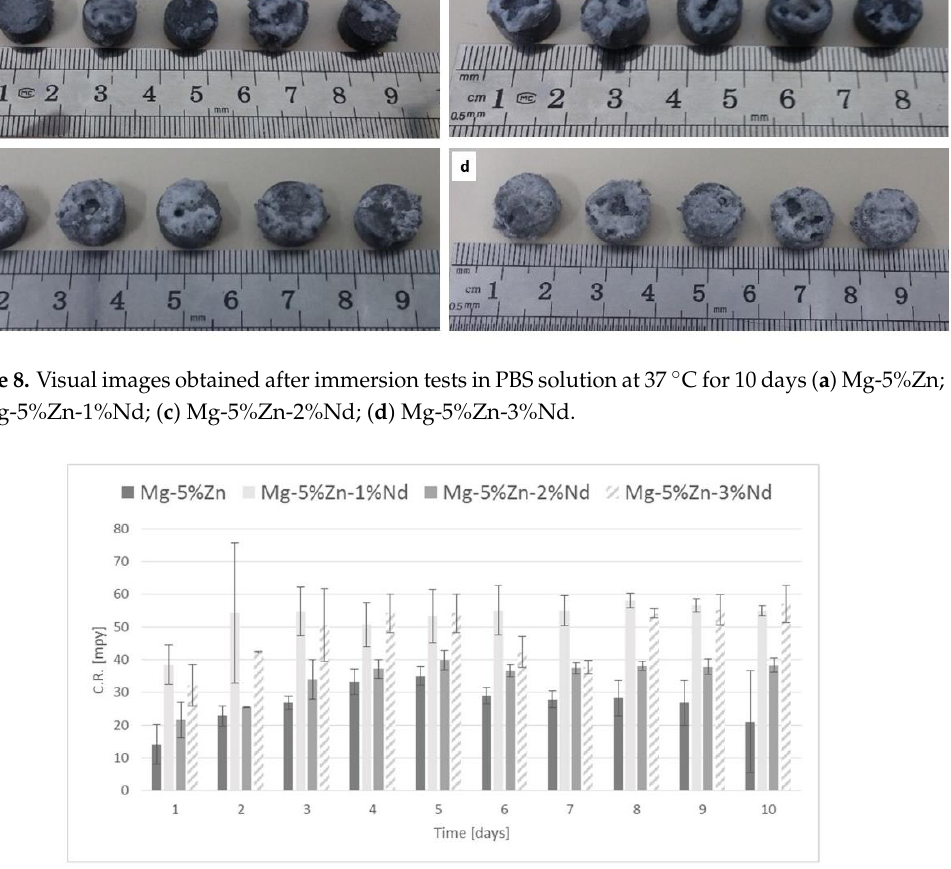
Figure 9. Corrosion rate measurements calculated from hydrogen evolution obtained during immersion tests in PBS solution at 37 °C.